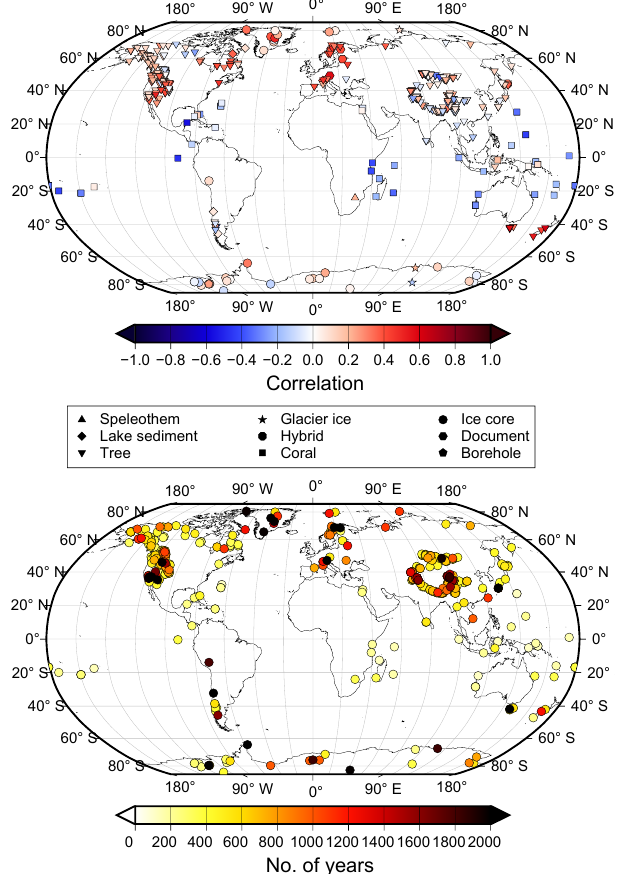
Figure 1. Top: pointwise correlation between the raw proxy series in the PAGES-SEL network and the SAT in the infilled HadCRUT4 dataset during the period 1911–1995. Each type of proxy is indi- cated with a different symbol. Bottom: number of years in which each record contains valid data, i.e. lighter colours indicate shorter